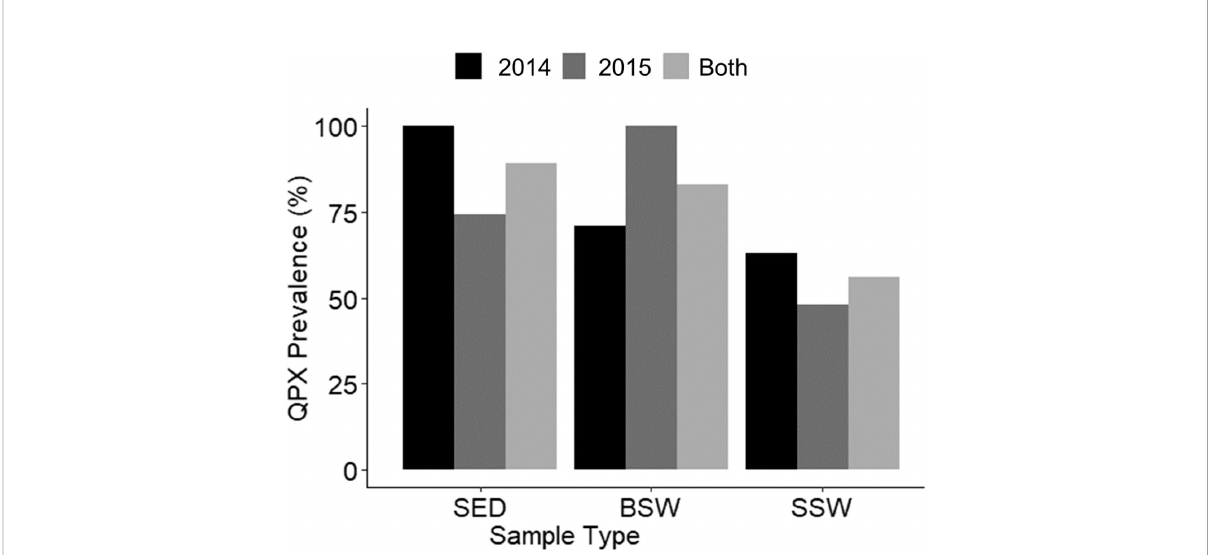
FIGURE 4 M. quahogii (QPX) prevalence (% positive samples) by sample type and year. SED represents sediment samples, BSW represents bottom seawater samples, and SSW represents surface seawater samples.